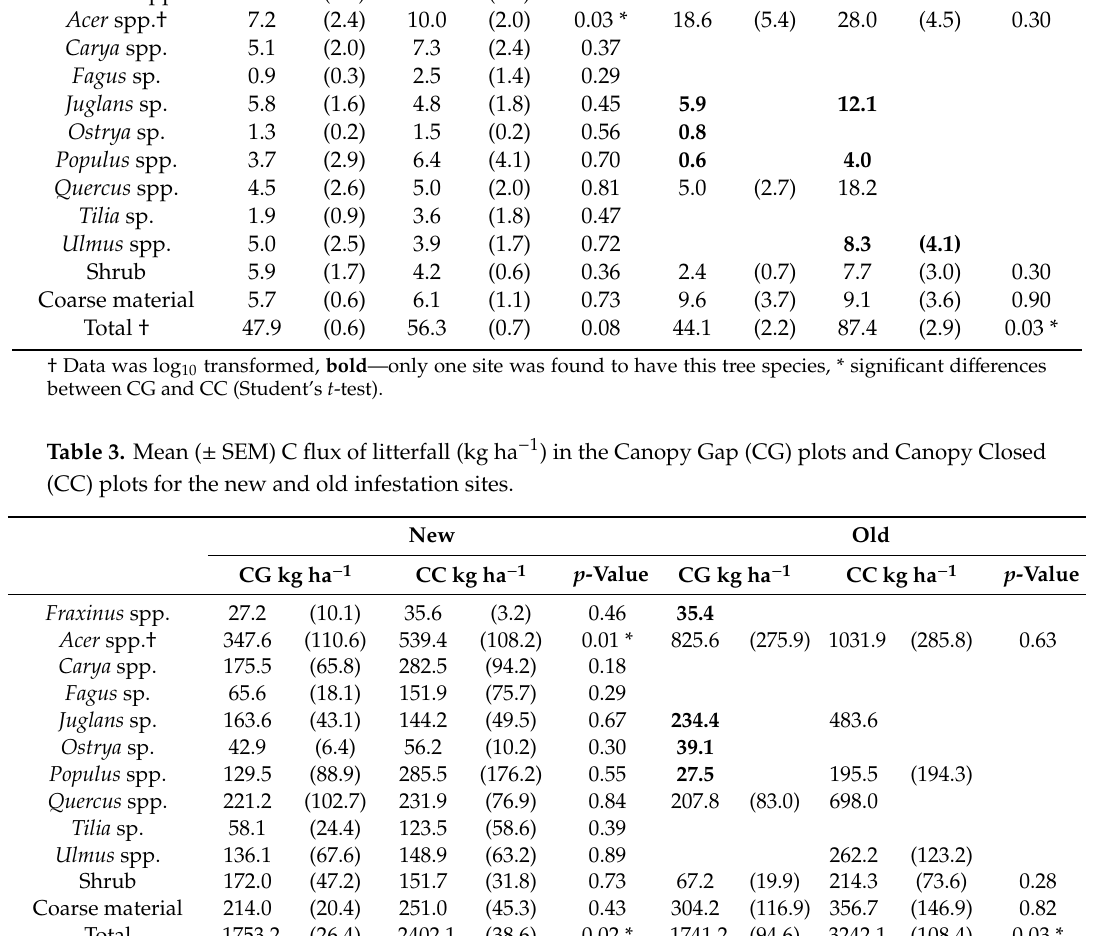
Table 2. Mean ( ± SEM) N flux of leaf litterfall (kg / ha − 1 ) in the Canopy Gap (CG) plots and Canopy Closed (CC) plots for the new and old infestation sites.